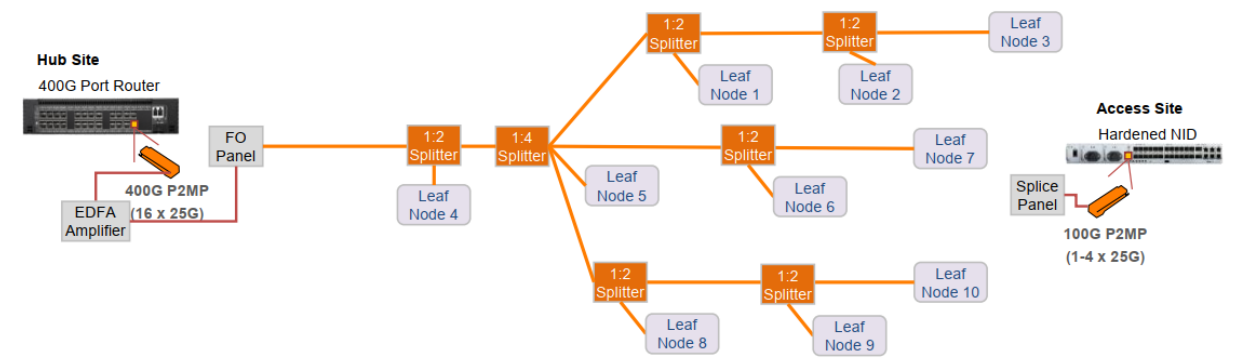
Figure 13. Network architecture of a Nyquist-WDM-PON [47]. OFDM-PON